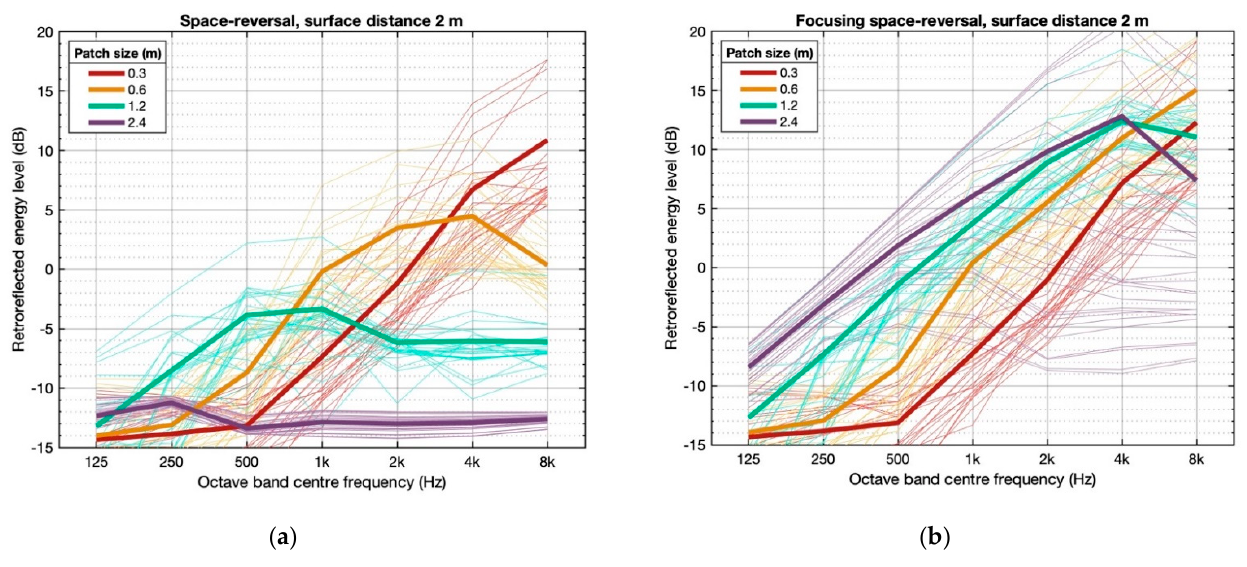
Figure 14. Octave-band distribution of retroreflected energy levels for 25 collocated source-receivers (small reflector), showing individual values (thin lines) and energetically averaged values (thick lines): ( a ) space-reversal patches ( b ) focusing space-reversal patches.